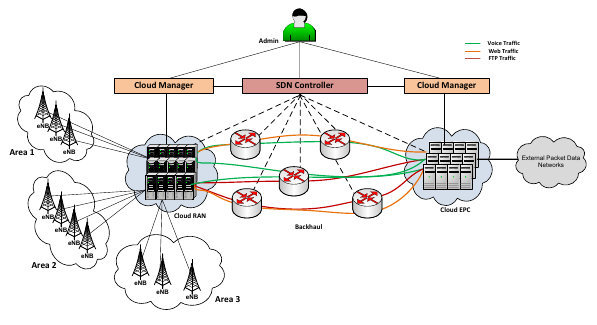
Figure 2. Cloud based mobile network Figure 3. (a). eNB architecture, (b) Each cloud platform connected with other cloud platform by using X2